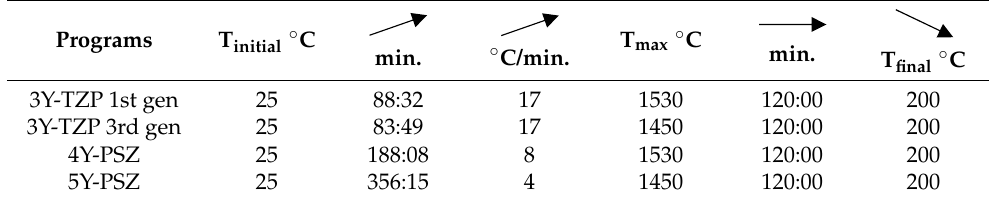
Table 2. Parameters of the sintering cycles indicated for each of the zirconias used in the present study. Programs T max °C T initial °C min. °C/min. min. T final °C 3Y ‐ TZP 1st